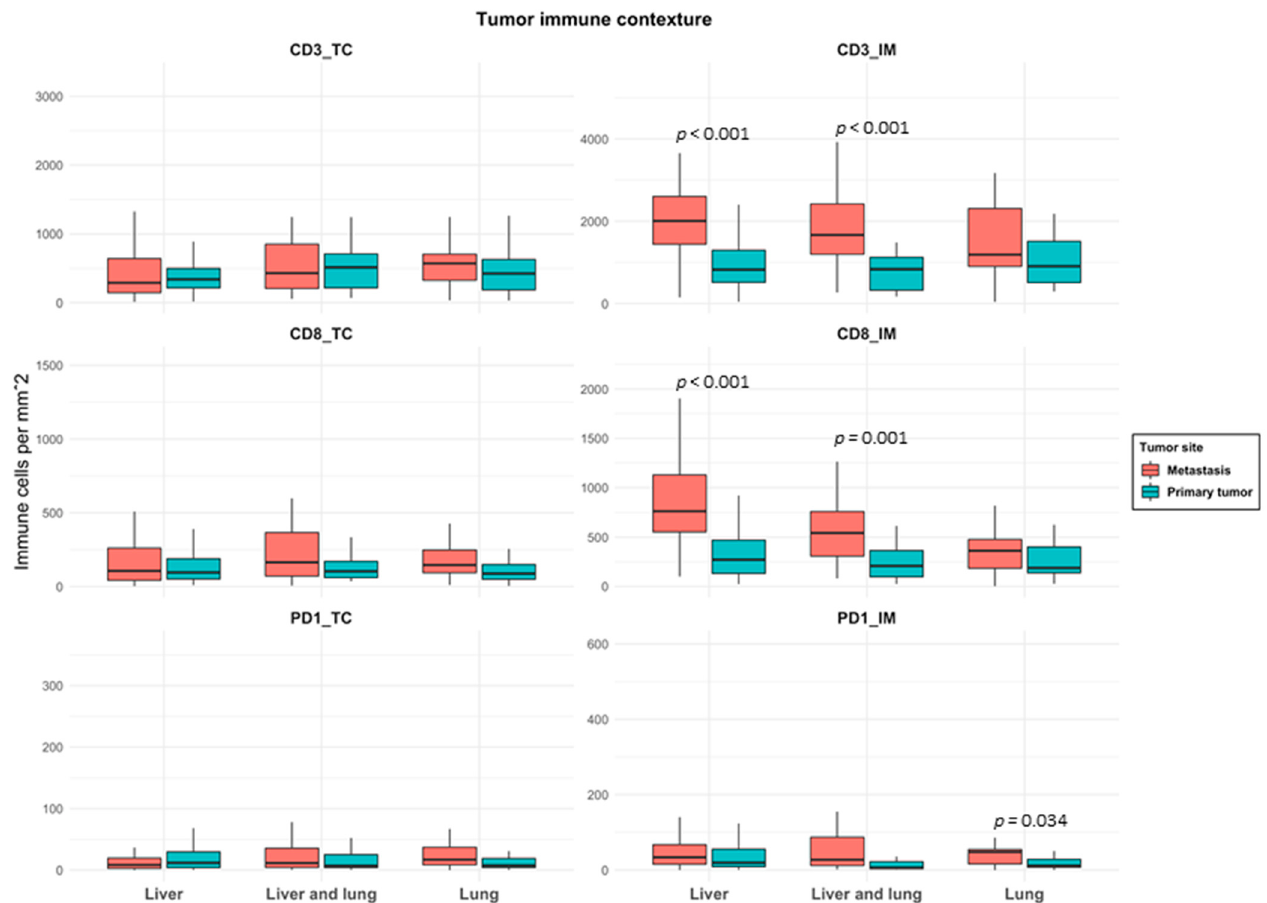
Figure 2. Box plot of immune cell densities in primary tumours and matched metastases in patients with liver-only, liver and lung and lung-only metastases. Horizontal line indicates the median, box the interquartile range (IQR) and whiskers the smallest/largest value no further than 1.5 × IQR. Abbreviations: TC: tumour center; IM: invasive margin. Table 2. Metastases’ characteristics.